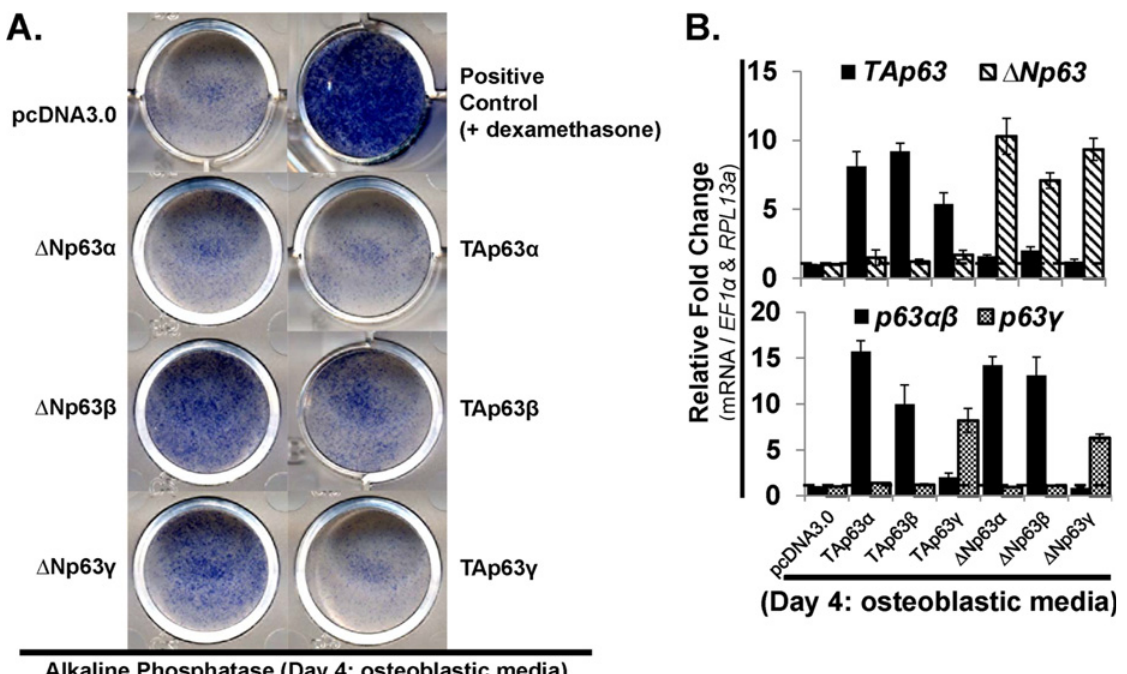
Fig 5. Transient overexpression of Δ Np63 β , - γ and TAp63 β increase alkaline phosphatase. hMSC were transfected with pcDNA3.0-p63 vectors (7 days), leading to transient overexpression of each of the six p63 variants. hMSC were then switched to osteoblastic differentiation media, no dexamethasone (4 days — post 7-day transfection). A) Alkaline phosphatase stain (Day 4 in osteoblastic differentiation media). Positive control for alkaline phosphatase consisted of osteoblastic differentiation media supplemented with dexamethasone (10nM). B) RT-qPCR analysis of p63 isoform (top panel, TA- and Δ Np63 ) and splice variant mRNA (bottom panel, p63 α / β and p63 γ ) expression. RT-qPCR analysis demonstrated the relative level of overexpression of each of the six p63 variants. A & B) Changes in alkaline phosphatase and mRNA expression of p63 variants are compared to hMSC transfected with the empty vector (pcDNA3.0). N = 3 independent experiments. RT-qPCR analysis was also used to assess the mRNA expression of the osteoblastic markers runx2 , osterix , osteocalcin , osteopontin , VDR and the late osteoblastic marker, BSP . No change above 2-fold was observed (data not shown). hMSC used were from a 22 year old